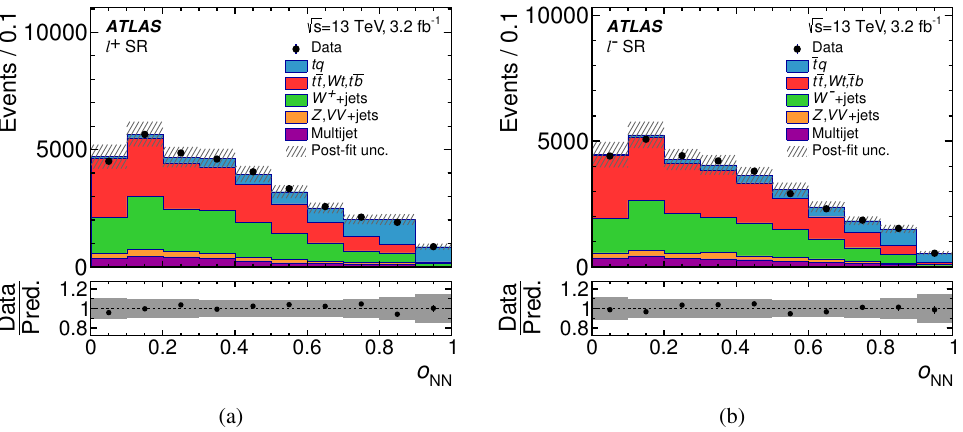
Figure 4 . NN discriminant distribution (a) for the ‘ + channel and (b) for the ‘ (cid:0) channel in the SR. The signal and backgrounds are normalised to the fit result and the hatched and grey error bands represent the post-fit uncertainty. The ratio of observed to predicted (Pred.) number of events in each bin is shown in the lower